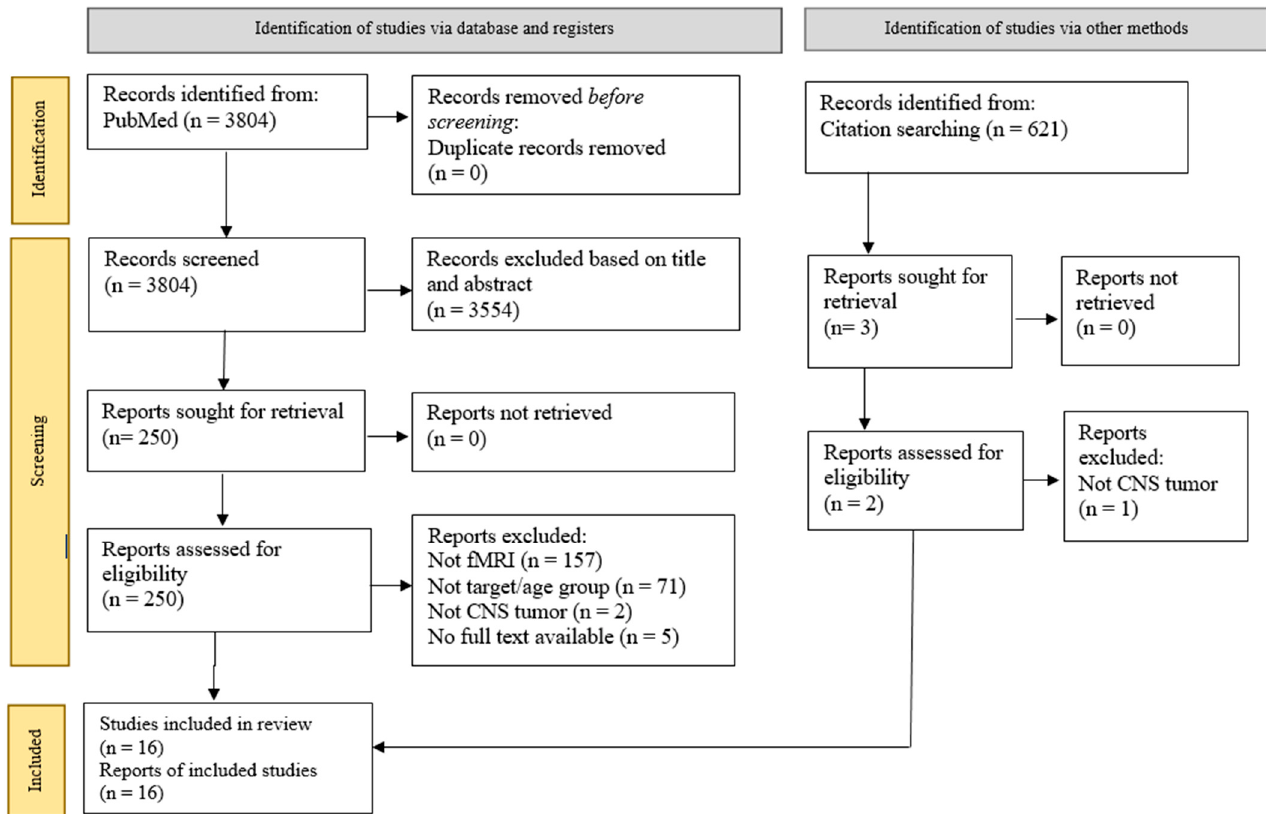
Figure 1. Flow diagram of the PRISMA study selection process.